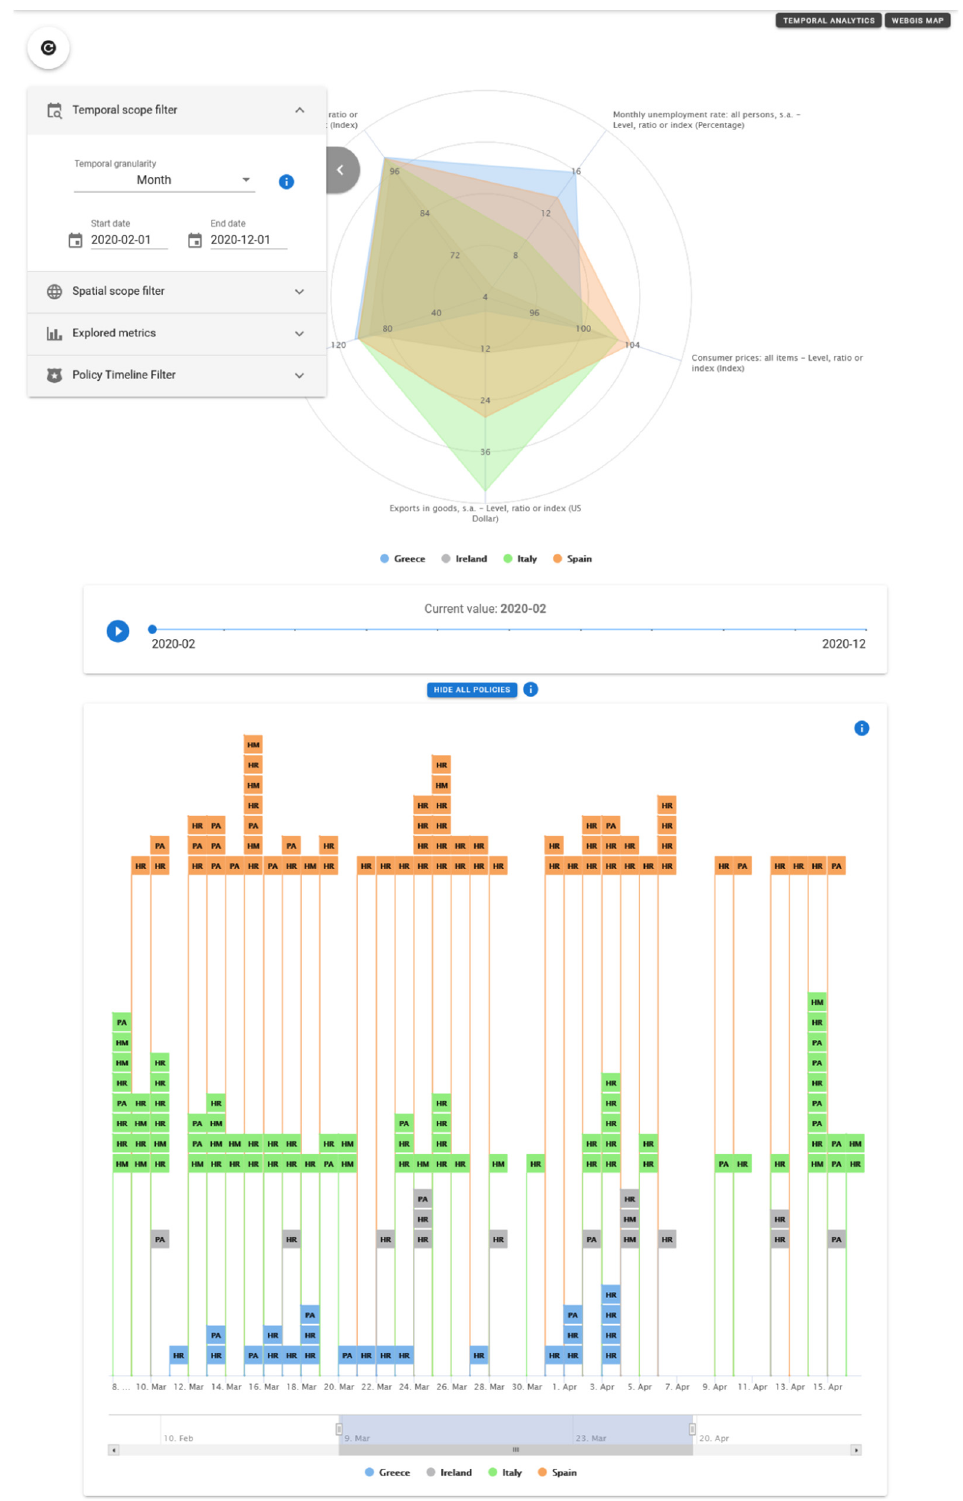
Figure 7. Example of visualization of the Multivariate Analytics page of the Atlas.